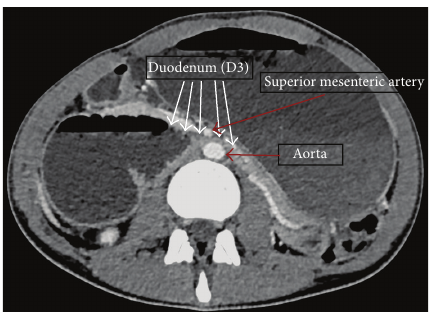
Figure 3: Axial CT section demonstrating the anatomy of SMA syndrome.